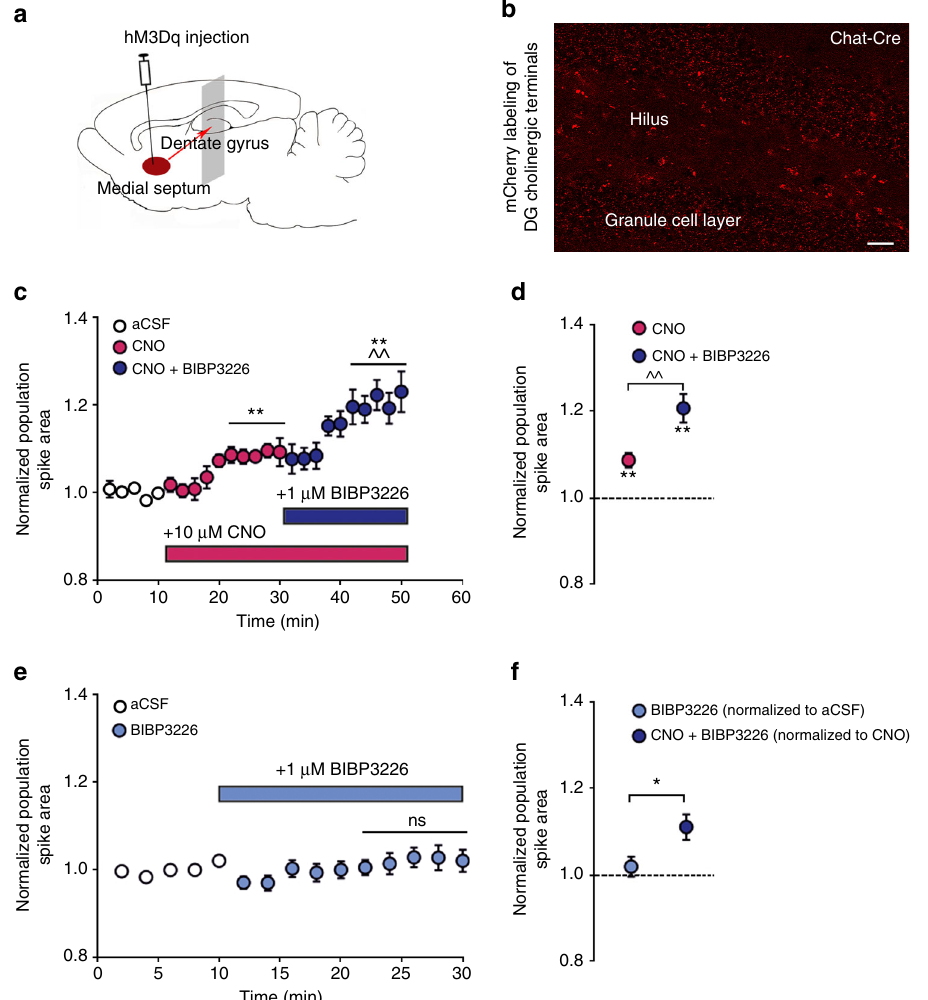
Fig. 6 Facilitatory effect of endogenous ACh-release on the DG population spikes is augmented by Y1 receptor blockage. a Schematic of conditional hM3Dq viral injection into the medial septum of Chat-Cre driver mice. b A representative microscopic image shows the expression of the virally expressed mCherry tag in cholinergic terminals throughout the dentate gyrus. Scale bar, 25 μ m. c The hippocampal cholinergic terminals expressing hM3Dq are activated by perfusion of hippocampal slices with CNO. Total of 10 µ M CNO results in a moderate increase of the DG population spike area, which is further augmented by 1 µ M BIBP3226 ( n = 8 slices). For statistical analysis the last 10 min of each condition are averaged and compared, to ensure full availability or the bath-applied drugs. d Summary graph illustrating the change in average population spike area after CNO and CNO + BIBP3226 application relative to aCSF. e By contrast, BIBP3226 application in the absence of CNO does not affect the population spike area ( n = 16 slices). f Comparison of normalized BIBP3226 effects on population spike area shows a signi fi cant change only after CNO application ( n = 16 slices without CNO and n = 8 slices with CNO). Values are means ± s.e.m. Statistical analysis was done with Fisher ’ s LSD following one-way repeated measures ANOVA (^^ P < 0.01: CNO vs. CNO + BIBP3226; ** P < 0.01; CNO or CNO + BIBP3226 vs. aCSF condition) in c and d , paired t -test in e and Student ’ s unpaired t -test in f (* P < HIPP cells in a S133 phosphorylation dependent manner. On the other hand, the observed increase of SST mRNA after transduc- tion of CREB S133A (similar to native CREB) may be indicative of a constitutive, phosphorylation independent regulation of SST expression 43 .